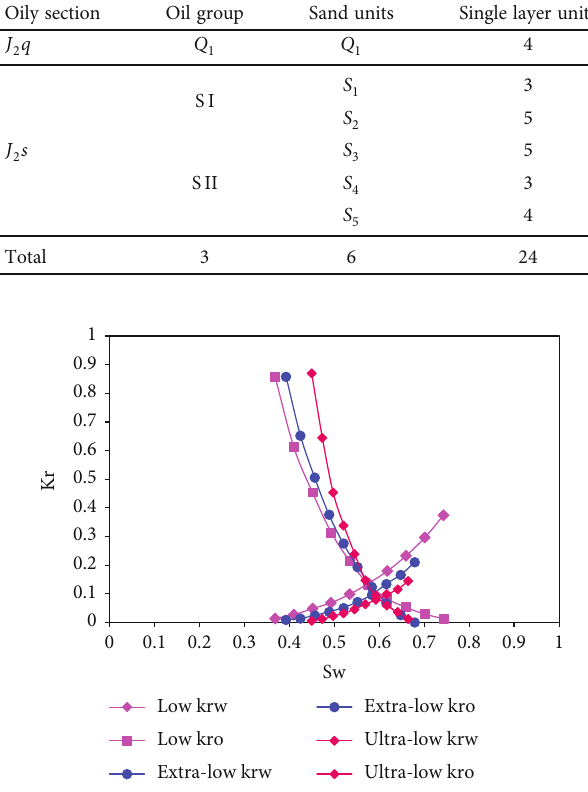
Figure 5: Relative permeability curves of three